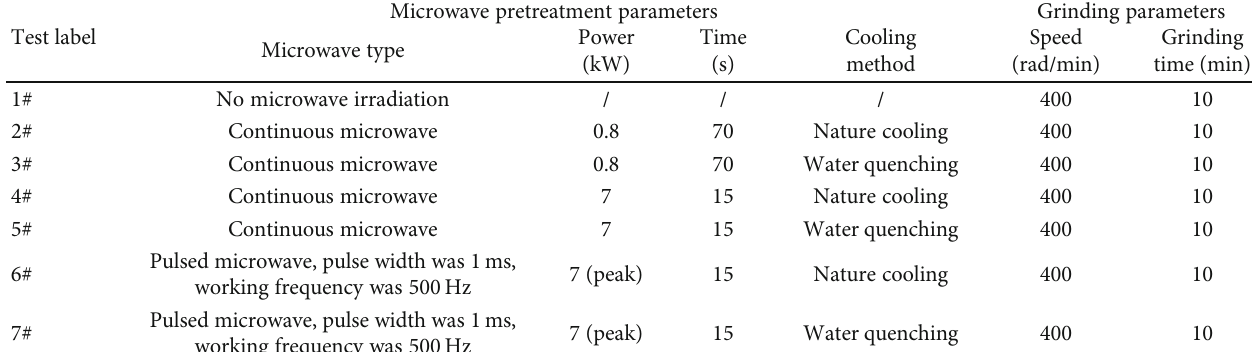
Table 2: Grinding test plan of lead-zinc ore with microwave pretreatment.